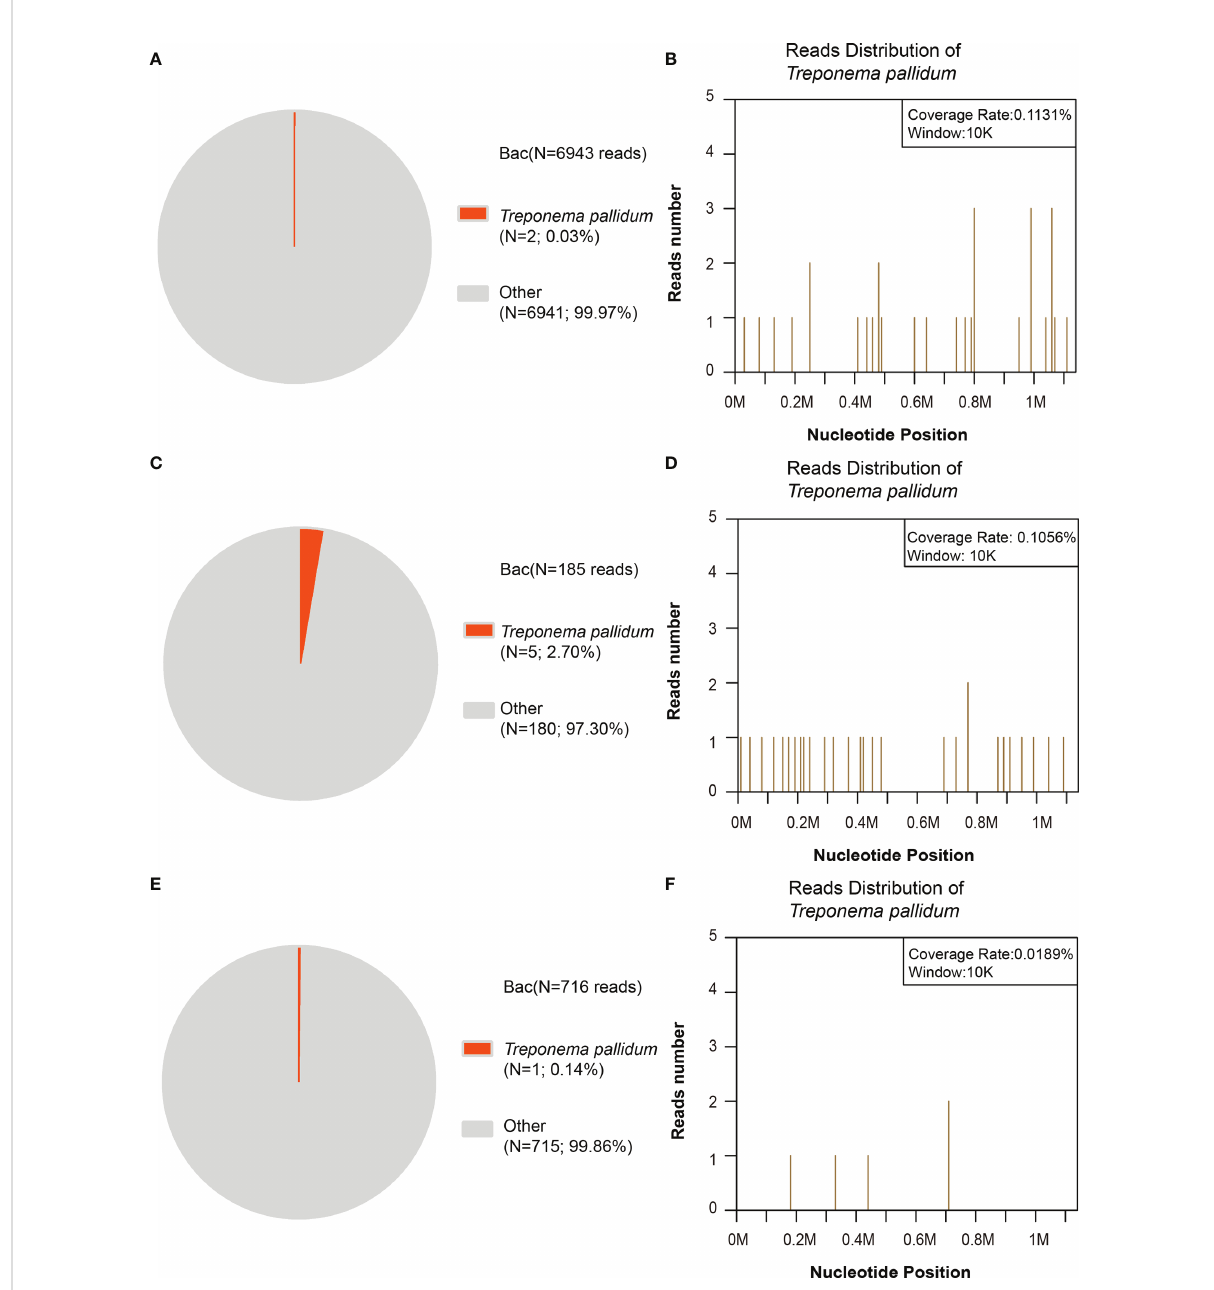
FIGURE 2 Next-generation sequencing (NGS) of the bacterial reads in the patients ’ cerebrospinal fl uid (CSF). (A, B) In patient no. 1, the distribution of bacterial reads (two of 6,943 reads; 0.03%) corresponded to Treponema pallidum with a coverage of 0.1131%. (C, D) In patient no. 2, the distribution of bacterial reads ( fi ve of 185 reads; 2.70%) corresponded to Treponema pallidum with a coverage of 0.1056%. (E, F) In patient no. 3, the distribution of bacterial reads (one of 716 reads; 0.14%) corresponded to Treponema pallidum with a coverage of 0.0189%. The others are commonly regarded as contaminating bacterial DNA from the environment and